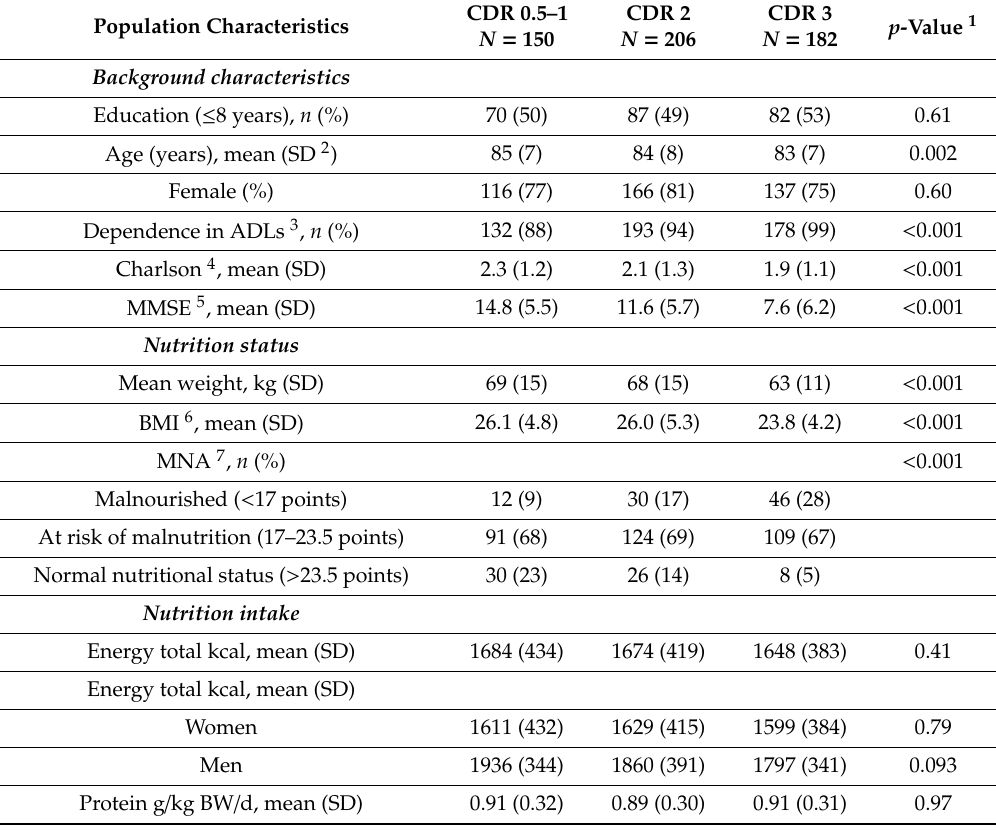
Table 1. Characteristics of the study population according to Clinical Dementia Rating